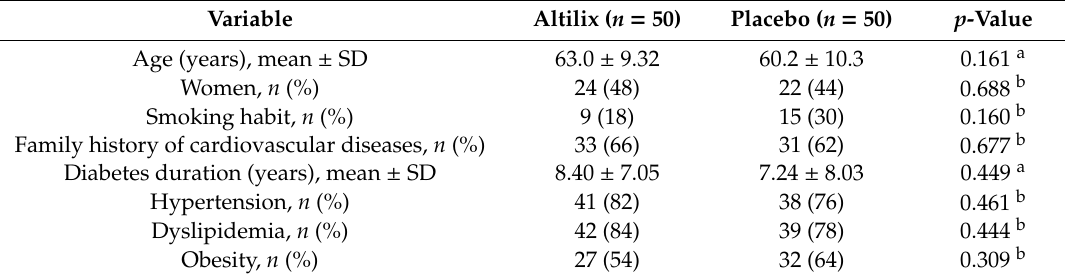
Table 1. Baseline characteristics of all subjects included in the study ( n = 100).